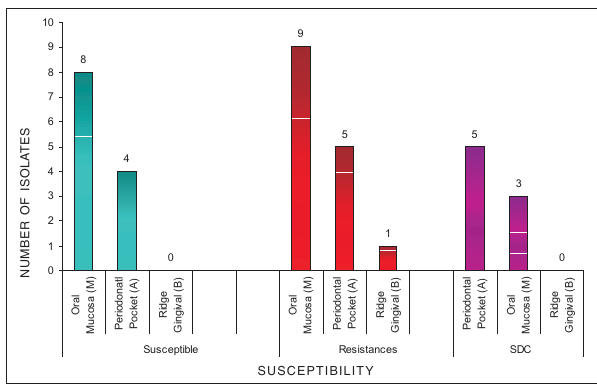
Fig. 2a - Susceptibility of C. albicans isolates to Ketoconazole for sites collected.